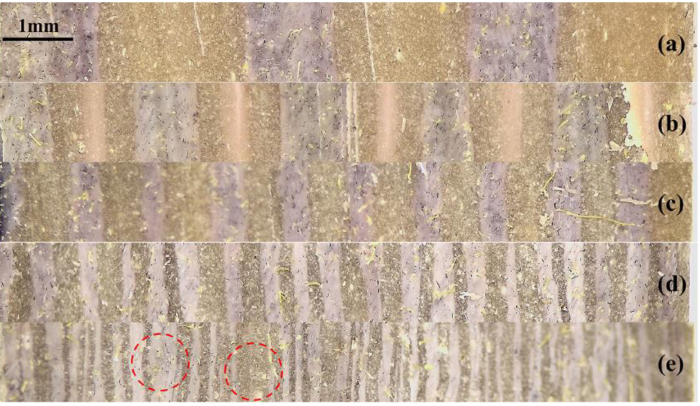
Figure 4. Optical microscopy image of the multilayer EPDM composites with different layers ((AM/HM) 6 : ( a ); (AM/HM) 10 : ( b ); (AM/HM) 20 : ( c ); (AM/HM) 40 : ( d ); (AM/HM) 80 : ( e )).